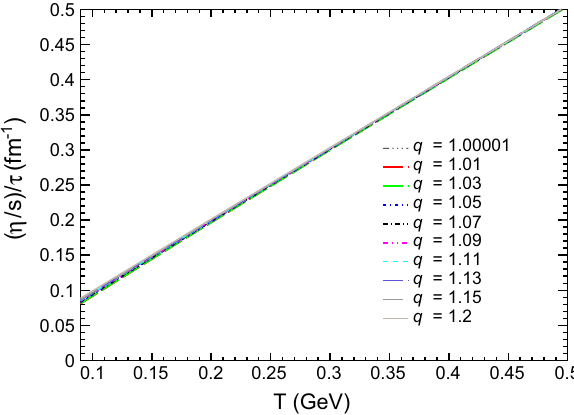
Fig. 2 (η/ s )/τ versus temperature for various q -values at zero baryon chemical potential